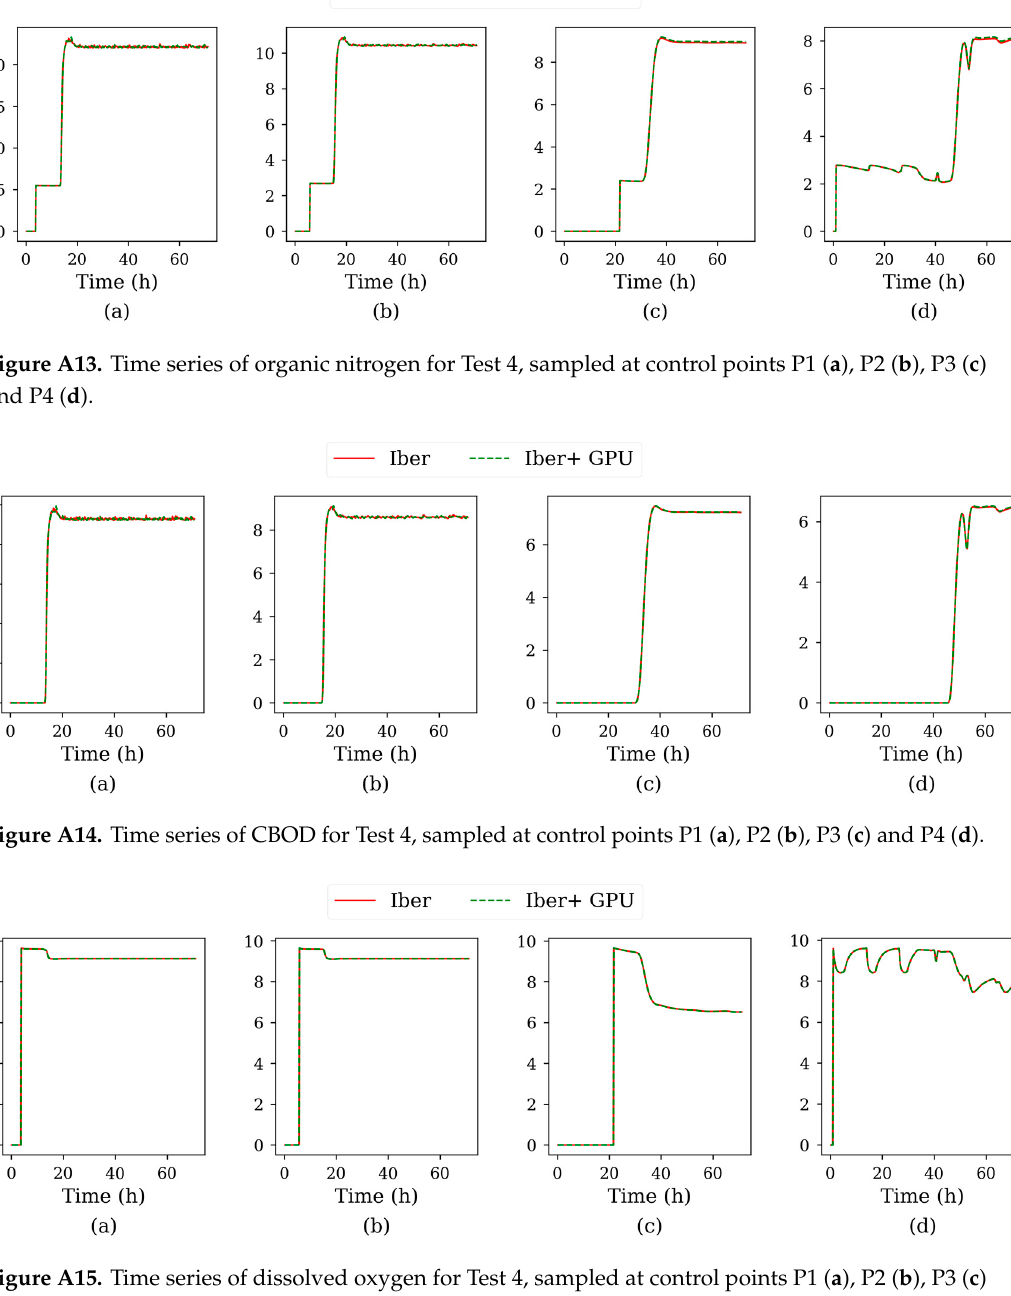
Table A1. Data sources for the Test Case 1.